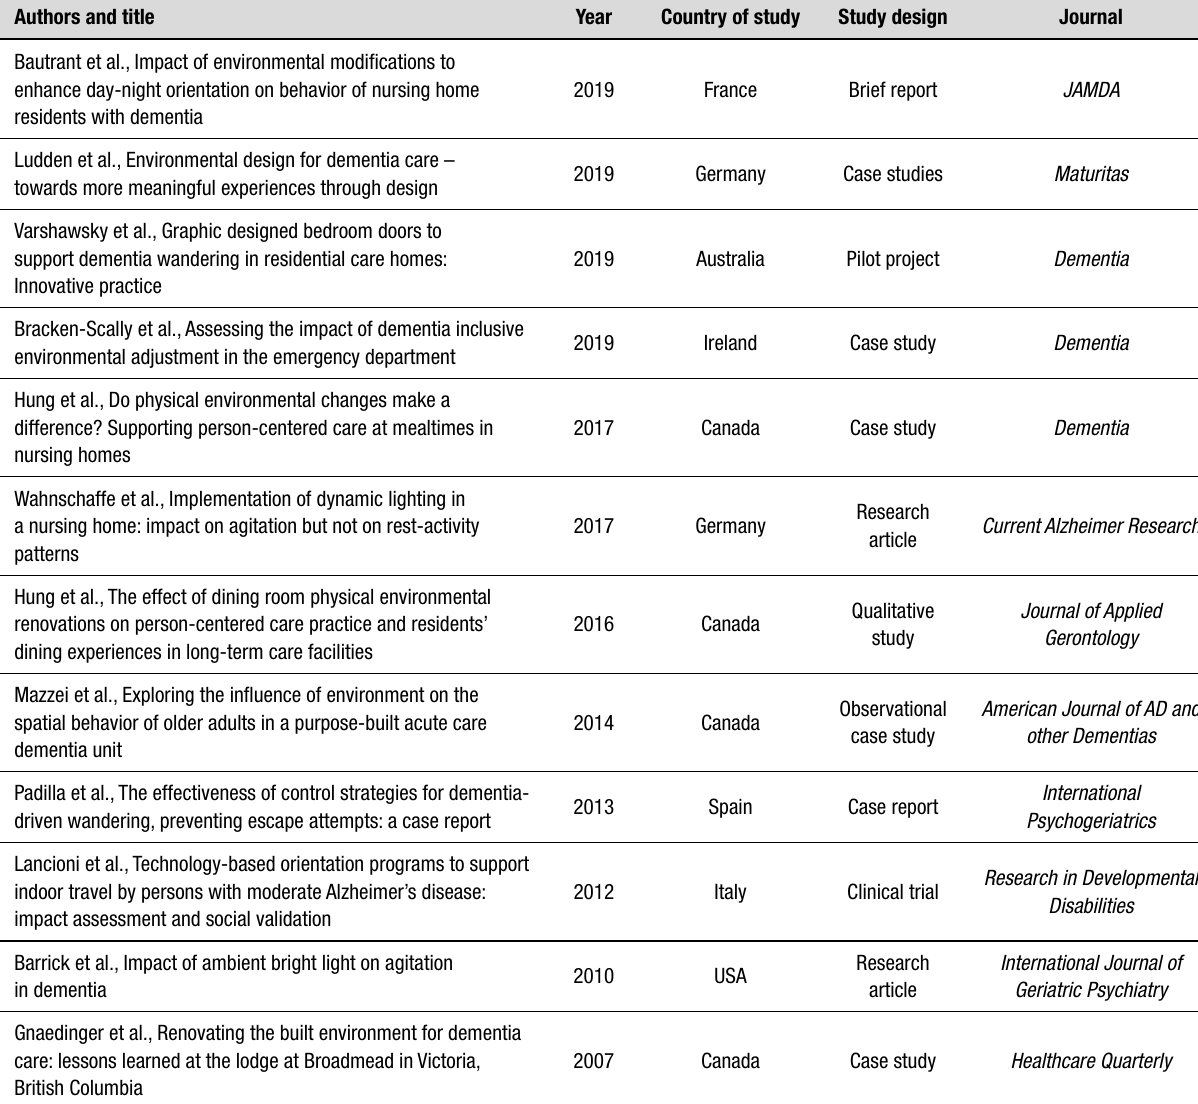
Table 1. List of articles included following the PRISMA